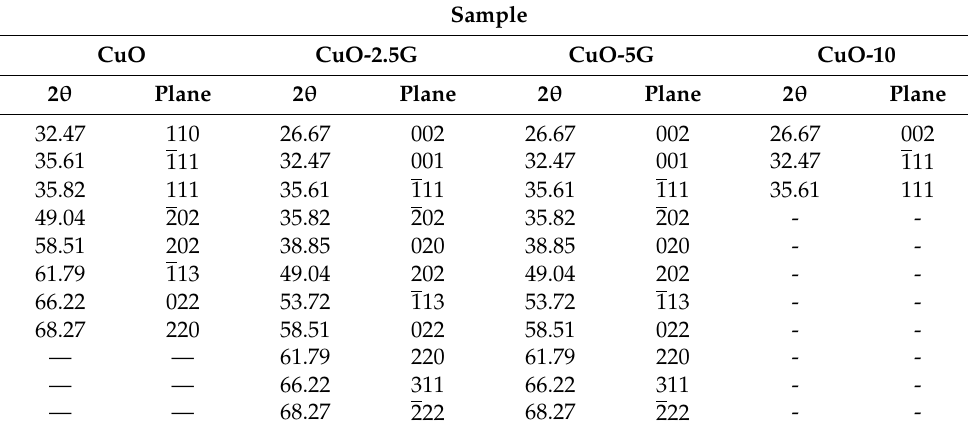
Table 2. X-ray diffraction peaks of the prepared samples and their associated crystal planes.